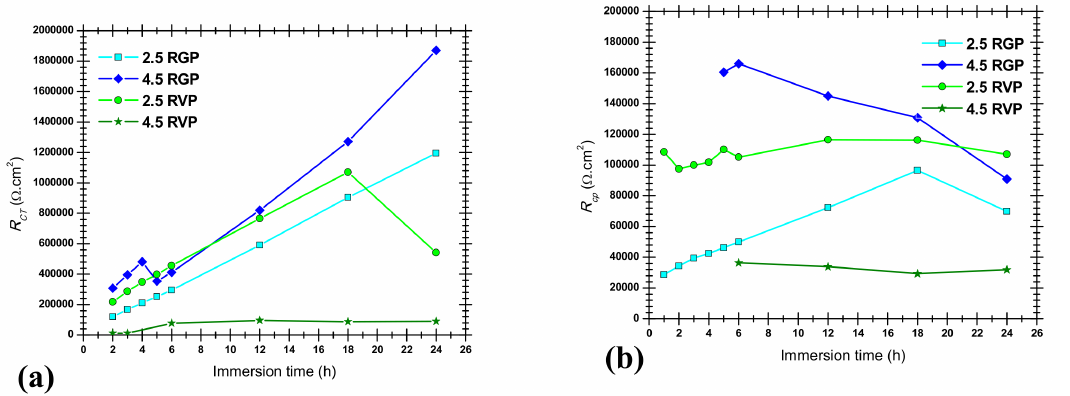
Figure 17. Fitted EIS parameters of ground thin wall samples: ( a ) R CT and ( b ) R CP .